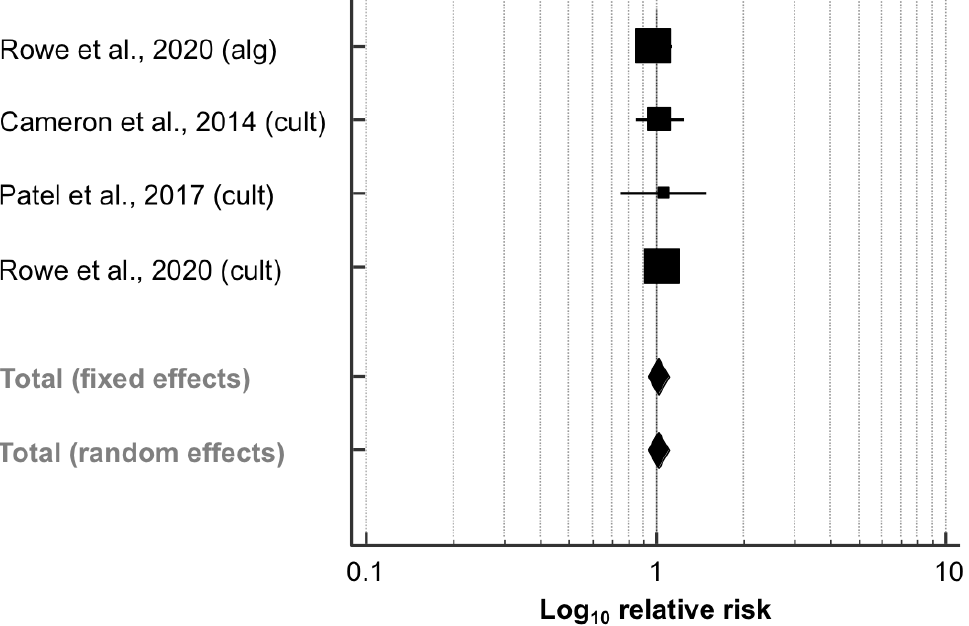
Figure 3. Effect of algorithm-guided (alg) and culture-based (cult) selective dry cow treatment (experimental group) compared to blanket dry cow treatment (control group) on the intramammary infection (IMI) risk after calving. The effect size of each study was summarized into a pooled relative risk (solid squares; marker size relative to study weight) and its 95% confidence interval (CI; whiskers) using a random-effects model. Overall effect size estimates and corresponding 95% CI are represented as the middle of the diamonds and their widths, respectively. Relative risks are plotted on a logarithmic scale, so that effects of the same magnitude but opposite directions are equidistant from